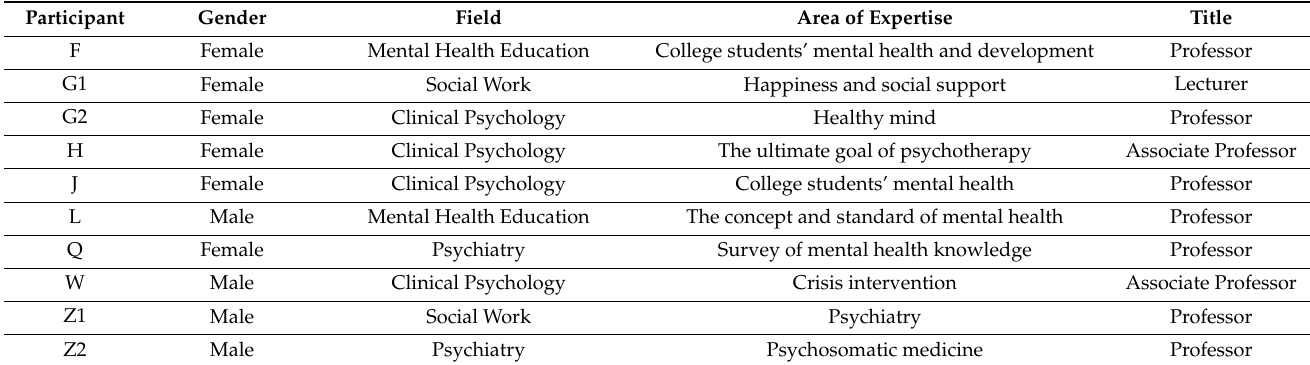
Table 1. Participants’ demographic characteristics ( n =